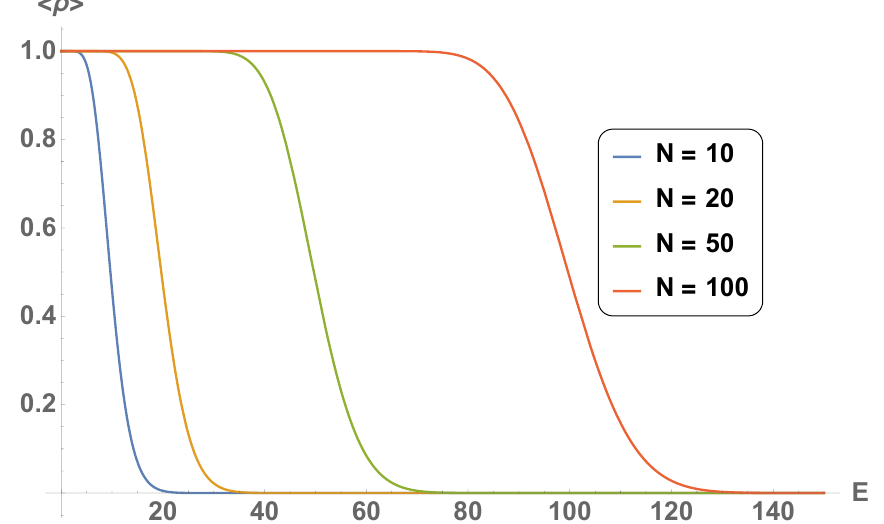
Figure 4 . Above we plot the average spectral density of a random spectrum generated from the i.i.d. model using the Poisson NNS distribution defined in eq. (3.5) (setting σ = 1 and E 0 = 0 and changing N ). The averaged spectral density is given by eq. (3.10). The width roughly scales with N